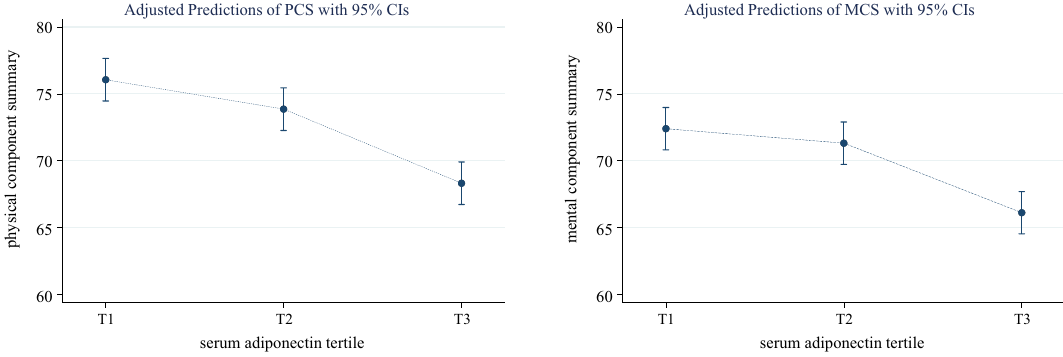
Figure 3. Adjusted predictions of physical component summary and mental component summary according to serum adiponectin tertile. Adjusted for age, sex, body mass index, marriage, economy, education, systolic blood pressure, diabetes, dyslipidemia, cardiovascular disease, estimated glomerular filtration rate, urine protein to creatinine ratio, C-reactive protein, hemoglobin, albumin current smoking, alcohol, and physical activity.